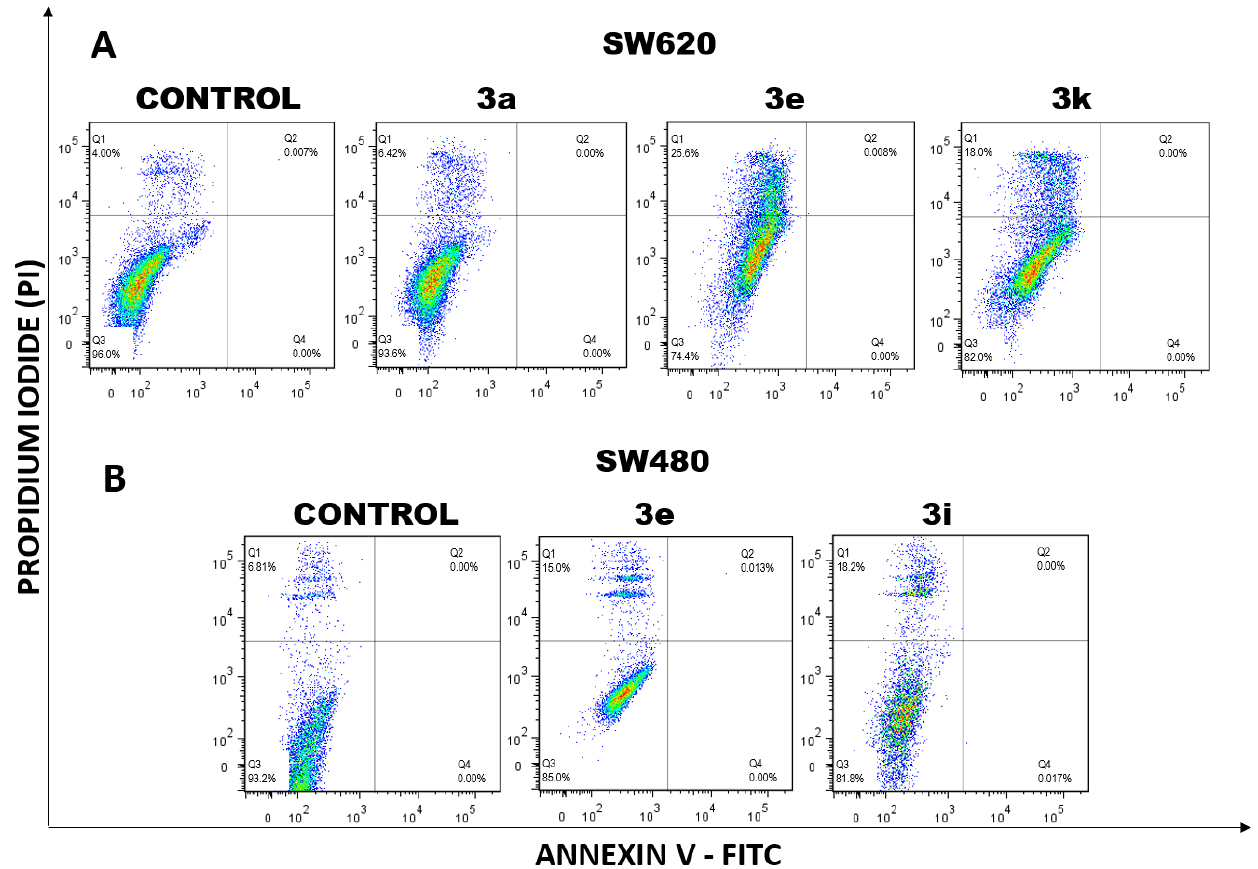
Figure 5. Apoptosis analysis of SW620 ( A ) and SW480 ( B ) cells in response to the treatment with curcumin/resveratrol hybrids. The histograms represent one of at least two different experiments. Q1 + Q2: Cells that lost membrane integrity (Late apoptotic cells, dead cells, necroptotic cells, sec- ondary necrotic cells, others); Q3: Viable cells; Q4: Early apoptotic cells. Control cells were